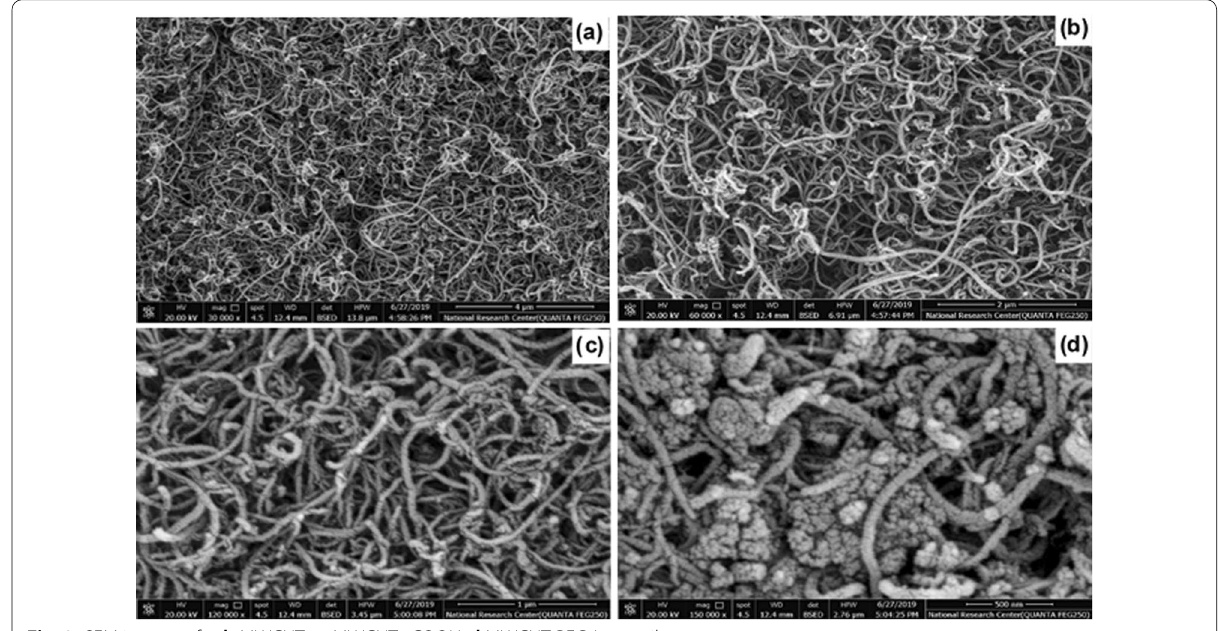
Fig. 3 SEM images of a , b MWCNTs, c MWCNTs-COOH, d MWCNT-PEG-Ixazomib